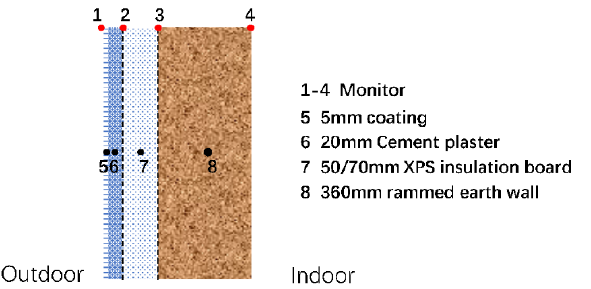
Figure 15. Schematic of the wall construction.